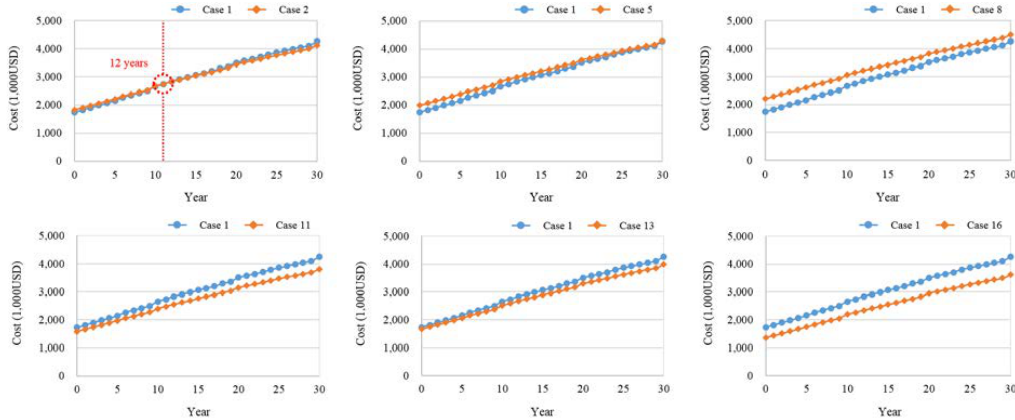
Figure 16. Comparison of LCC and Periods of the Recovery of Initial Investment.